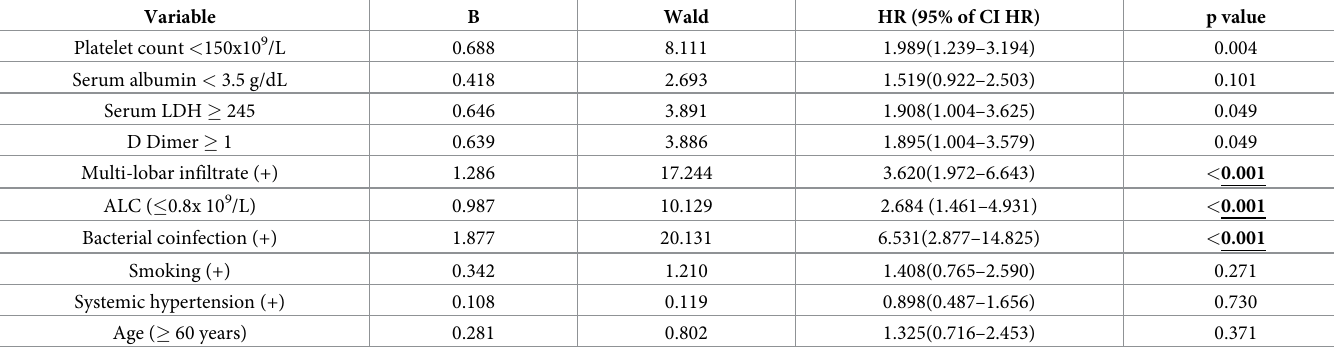
For validation and deriving modified score linear regression analysis was done and the results are shown in Table 4. The score was modified as per beta coefficient and new scoring system was derived. The new MuLB score of 8 was associated with high risk of poor survival (S2 Table). Table 3. Multivariate analysis—Prognostic factors for mortality on day of admission.